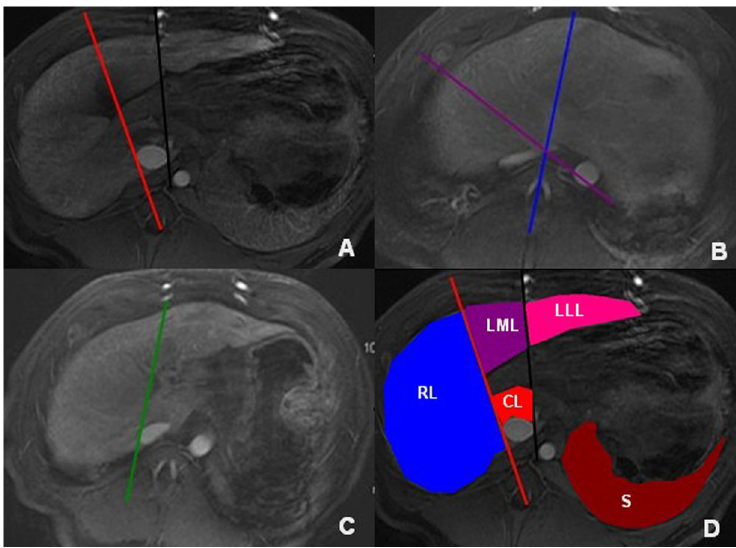
Figure 1. The division of liver lobes. Middle liver fissure (red line), and liver interlobar fissure (black line) are used as a landmark to differentiate right liver lobe from left liver lobe, and left lateral liver lobe from left medial liver lobe on the level of the fossa for gallbladder, respectively (A). Middle liver vein (purple line), and left liver vein (blue line) are used as a landmark to differentiate right liver lobe from left liver lobe, and left lateral liver lobe from left medial liver lobe on the level of the second liver portal, respectively (B). The line (green line) linking the inferior vena cava to the right branch of the portal vein is used as a landmark to differentiate right liver lobe from the caudate lobe on the level of the first liver portal (C). Outlines of four hepatic lobes, and of spleen are delineated on the axial enhanced magnetic resonance imaging (D) (RL, right liver lobe; LML, left medial liver lobe; LLL, left lateral liver lobe; CL, caudate lobe; and S,